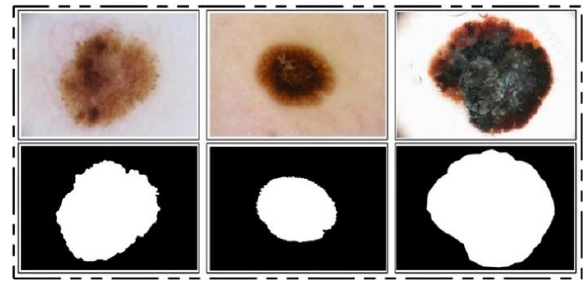
Figure 1. Sample images of ISBI 2016 for skin lesion segmentation.